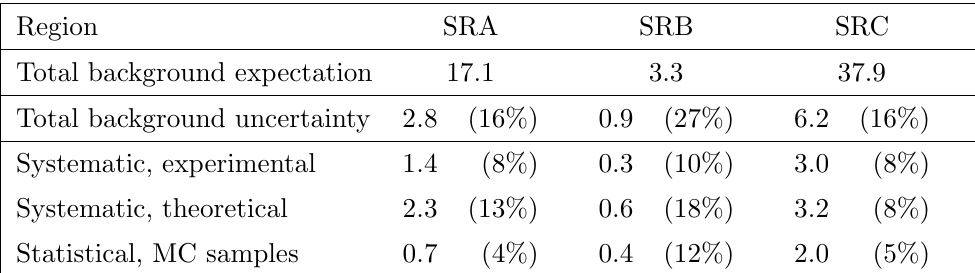
Table 5. Expected background event yields and dominant systematic uncertainties on background estimates in the A-type (inclusive), B-type and C-type (inclusive) regions. Individual uncertainties can be correlated, and do not necessarily add up quadratically to the total background